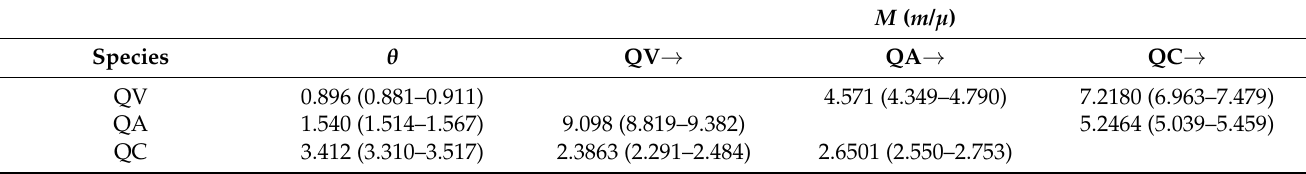
Table 2. Historical gene flow as estimated by Migrate-n among three related species. QV, Q. variabilis ; QA, Q. acutissima ; QC, Q. chenii ; numbers in parentheses are the lower 5% and upper 95% of posterior distribution; M , mutation-scaled immigration rate; m , immigration rate; µ , mutation rate; → , source populations.